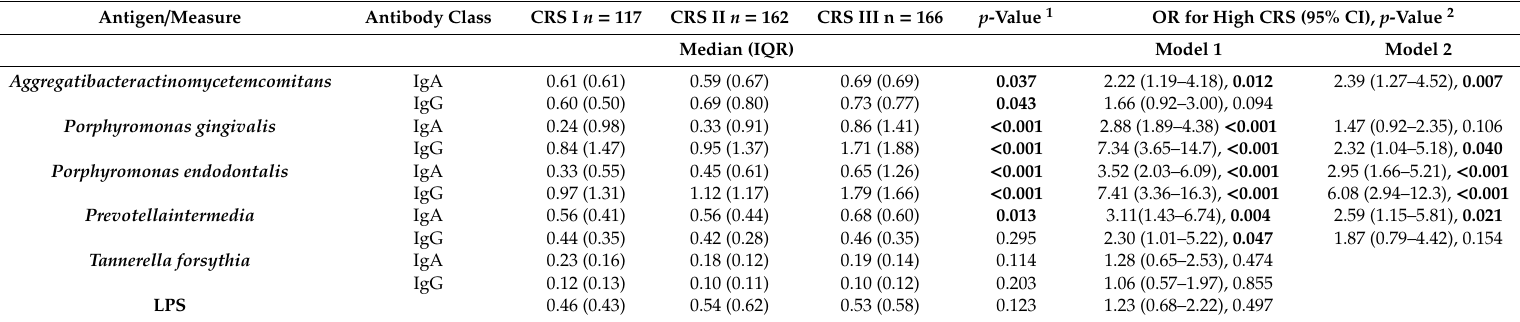
Table 2. Serum antibody levels in response to five periodontal pathogens and lipopolysaccharide (LPS) levels according to the CRS.